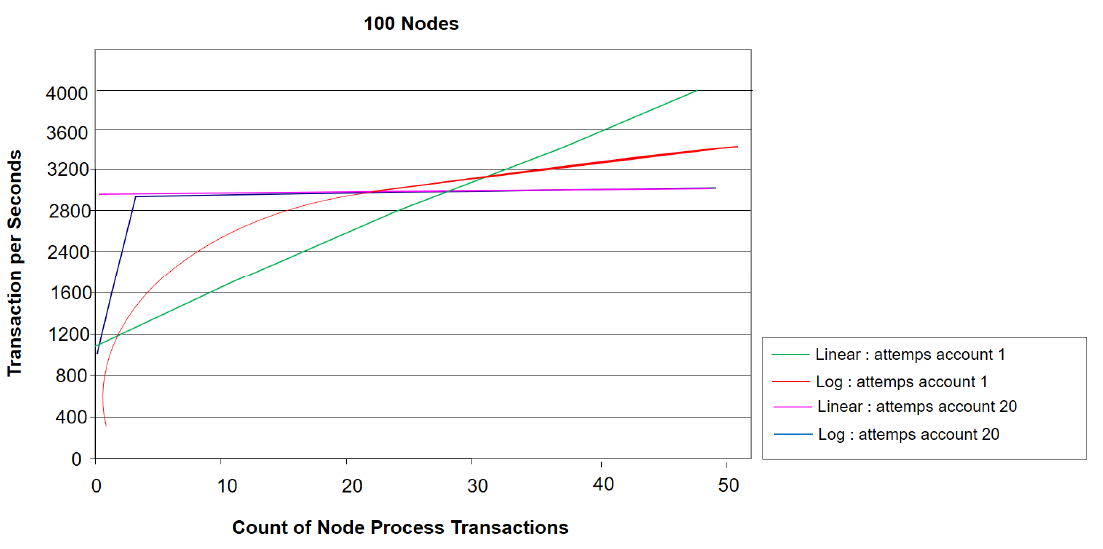
Figure 15. Average value for 100-node.